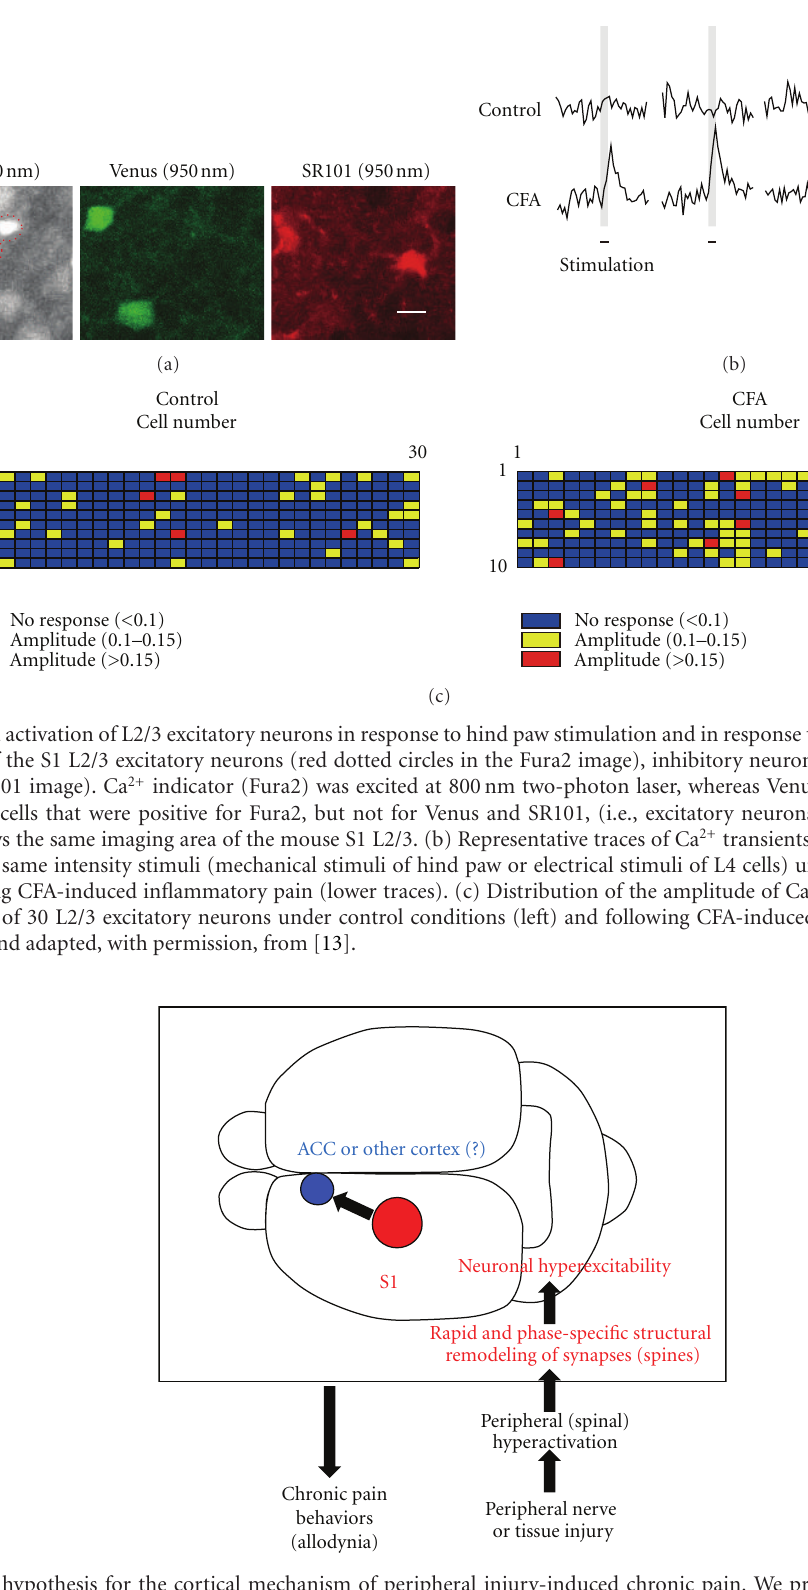
Figure 4: Working hypothesis for the cortical mechanism of peripheral injury-induced chronic pain. We propose that peripheral injury (nerve ligation or inflammation) induces rapid structural and function remodeling of S1 cortical synapses as described in the text. This, alongside possible other contributions of inhibitory interneurons and glia, results in hyperexcitability of excitatory S1 cortical neurons. These may project and interact with other regions within the pain “neuromatrix”, such as the ACC, to result in chronic pain behaviors such as